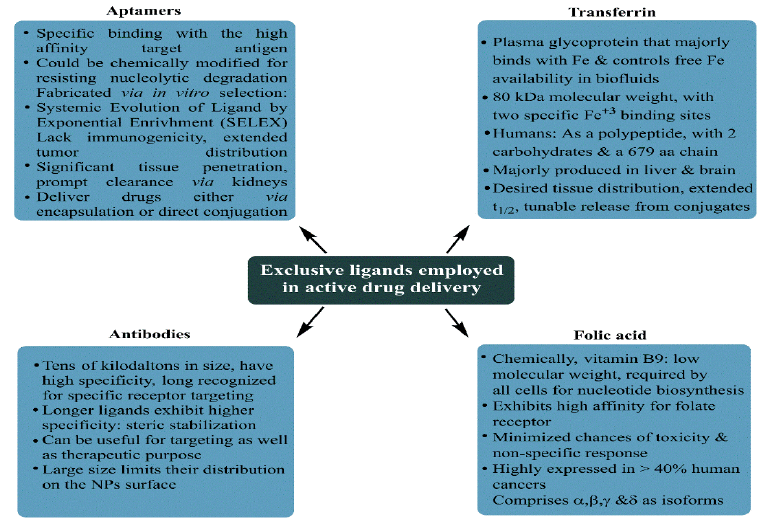
Figure 8. Potential ligands withan anticipated suitability for active drug delivery with mesoporous silica nanoparticles. While antibodies have a long history ofusage, recent suitability in folate receptors alongwith the architecture of aptamers has minimized toxicity and non-specific responses.